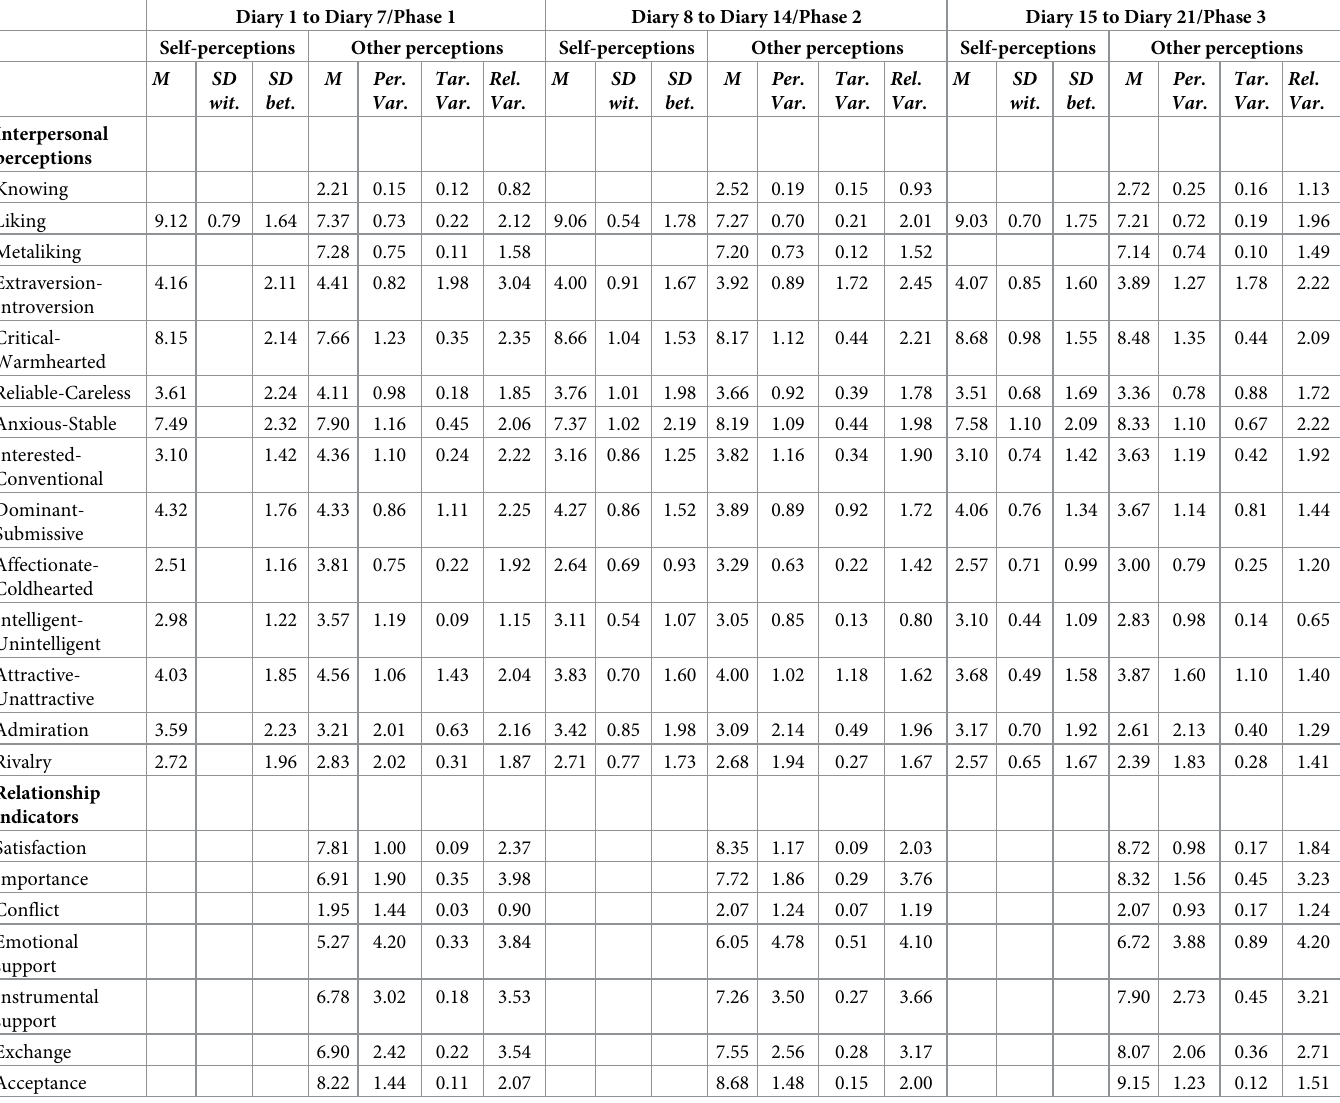
Table 15. CONNECT selected time-based assessment